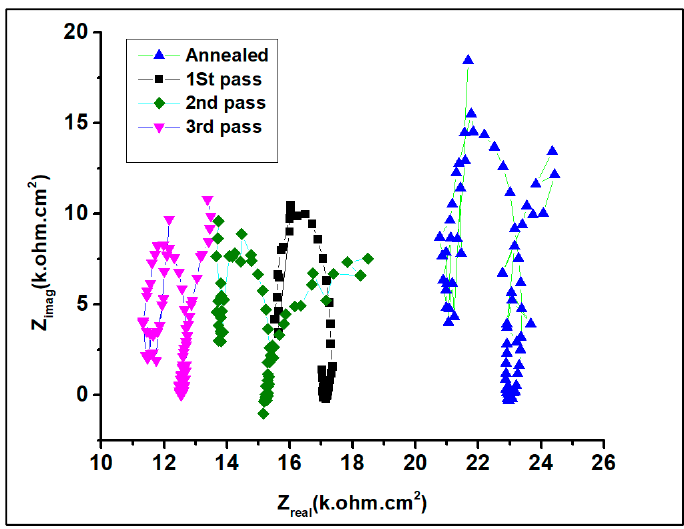
Figure 6. Nyquist plot curve of the Al5083 alloy in the 3.5% NaCl solution.